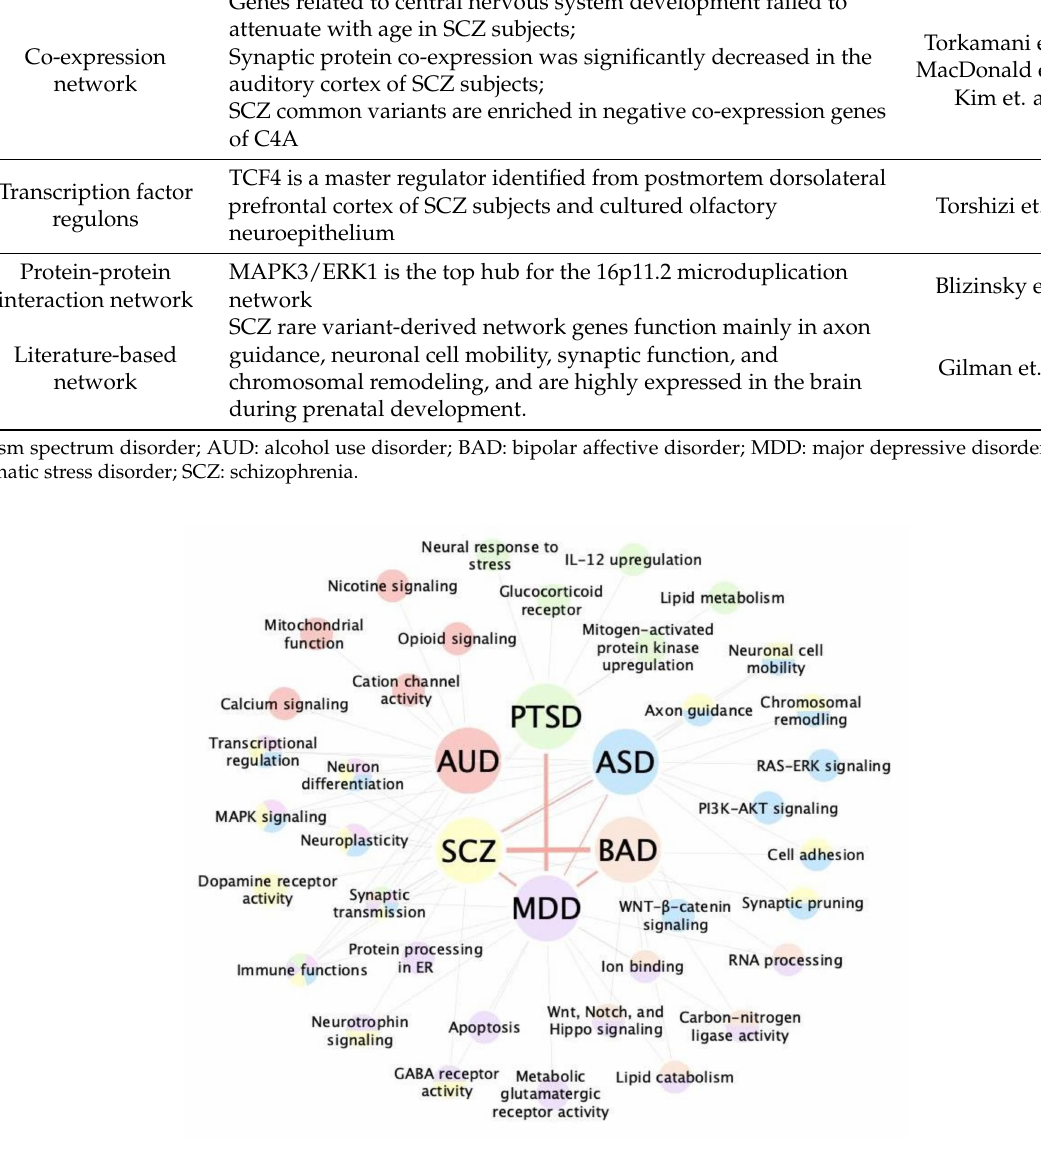
Figure 4. Comparing shared and distinct pathways across selected psychiatric disorders. Top pathways related to selected psychiatric disorders are shown in the disorder-pathway network. Red lines connecting disorders depict the correlation level between disorders [112]. Synaptic transmission- related processes are shared among all six disorders and immune functions are indicated in all disorders except BAD. Pathways including MAPK signaling and transcriptional regulation are shared among the AUD, ASD, and SCZ. Each disorder and its associated pathways are annotated with the same node color. Shared pathways between disorders are indicated with multi-color nodes. ASD: autism spectrum disorder; AUD: alcohol use disorder; BAD: bipolar affective disorder; MDD: major depressive disorder; PTSD: post-traumatic stress disorder; SCZ: